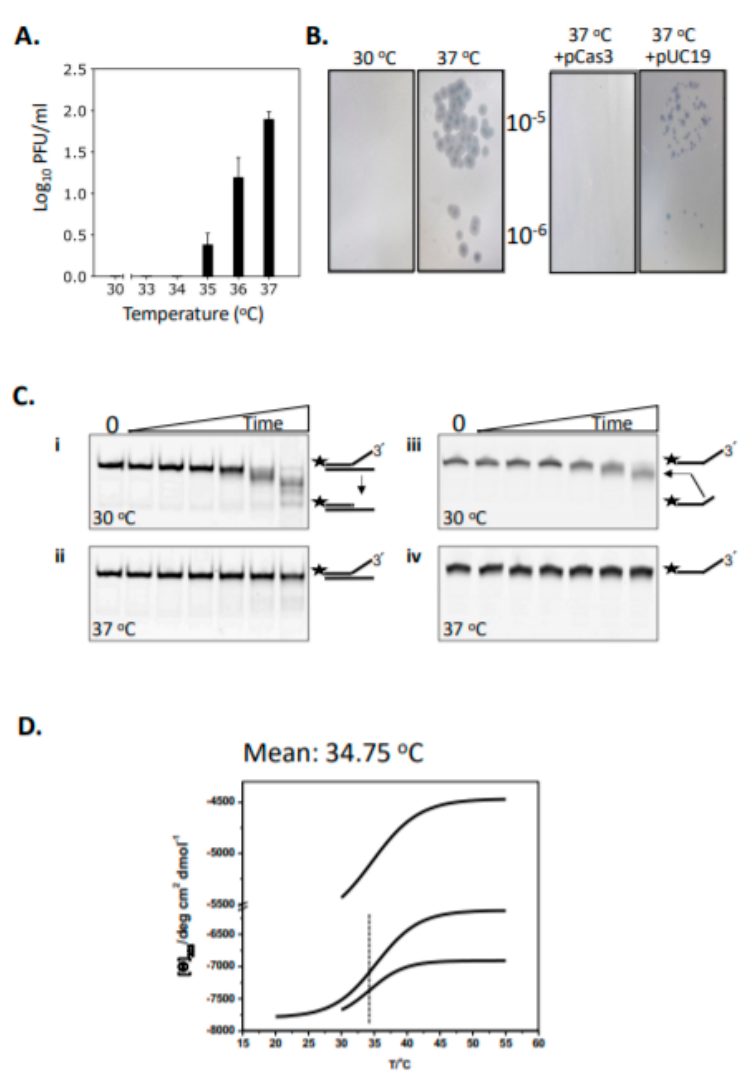
Figure 1. Temperature-induced changes to Cas3 structure and function in E. coli cells and in vitro. ( A ) ∆ vir plaque formation was measured at 30-37 ◦ C as a read-out for the efficacy of CRISPR interference. Plaques (PFU, plaque forming units) were readily observed at and above 35 ◦ C (see also part B ). Assays were in triplicate and standard errors from the mean are shown. ( B ) (i) Plaques formed as measured in part A at 37 ◦ C were not observed if the cells also over-expressed Cas3 from a plasmid (ii, +pCas3), compared with the empty plasmid vector (pUC19) used as a control (iii). ( C ) Cas3 nuclease activity degrades Cy5 end-labelled (25 nM, label denoted by a star) DNA much more effectively at 30 ◦ C compared to 37 ◦ C, in reactions containing 56 nM of Cas3 with samples taken at 0, 5, 15, 30, 60, 120 and 240 min. Panels i and ii show native TBE polyacrylamide gels, and iii and iv are denaturing (urea) TBE gels. ( D ) Shows the Boltzmann curve traces from each of three independent experiments for E. coli Cas3, derived from circular dichroism spectroscopy measurements at 222 nm. The mean temperature for the inflection point is shown—34.75 ◦ C—and see Supplementary Figure S2 for the full plotted